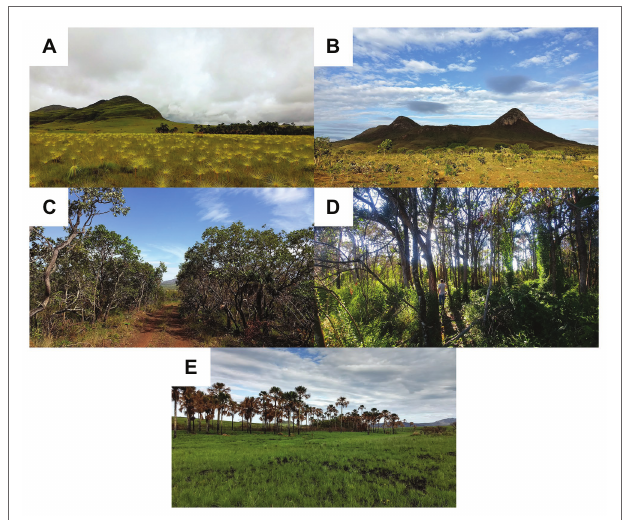
FIGURE 1 | The five main phytophysiognomies of the Cerrado biome: Campo Limpo (A) , Campo Sujo (B) , Cerrado Strictu Sensu (C) , Cerradão (D) , and Veredas (E)